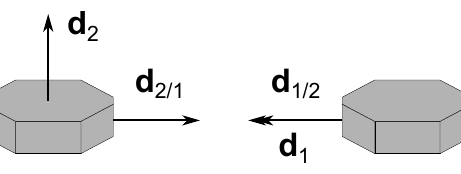
Figure 2. Example of a degenerate branch 1–2.